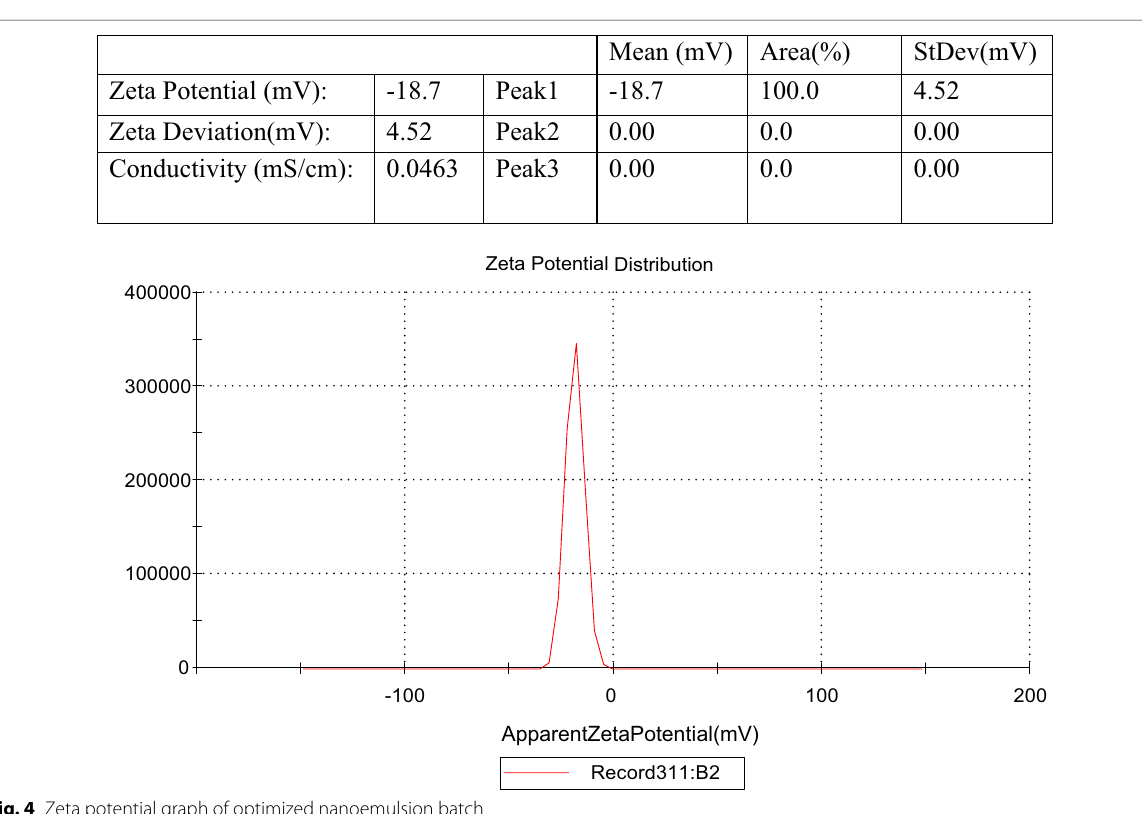
Fig. 4 Zeta potential graph of optimized nanoemulsion